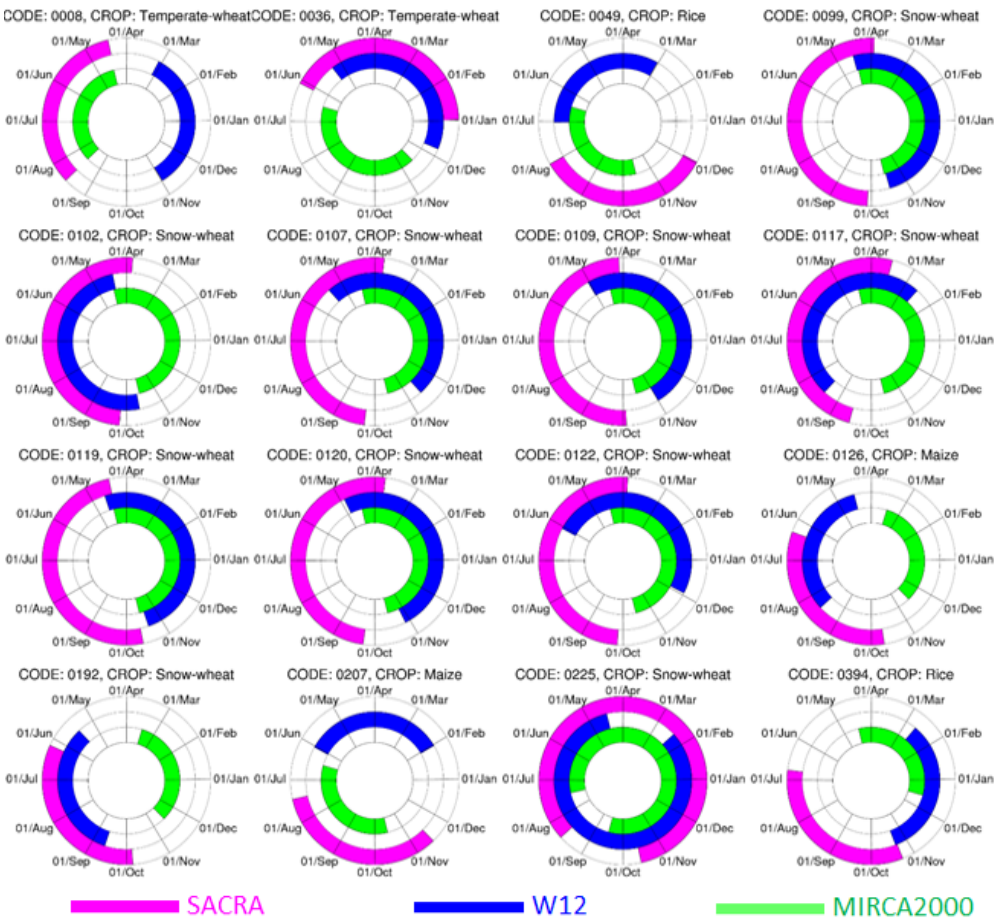
Figure A4. Cultivation seasons (from sowing to harvesting dates) in 16 administrative units in Table 5. Magenta, blue, and green denote SACRA, Waha et al. (2012) and MIRCA2000, respectively. For Waha et al. (2012), we apply the cultivation period of MIRCA2000 for purposes of illustration at each administrative unit. The beginning and end of the labels represent averaged sowing and harvesting dates, respectively, over the administrative unit. Only single cropping grids are used to compute the averaged sowing date for